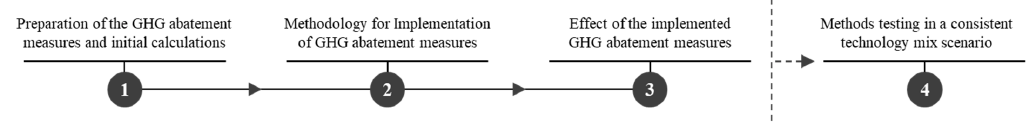
Figure 3. Overview of the methodological procedure.